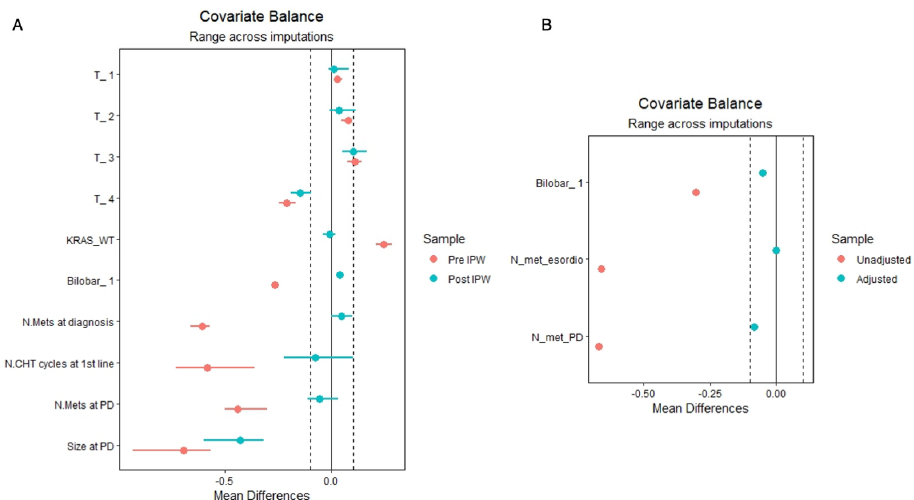
Figure 2. Love plots representing the effect of the weighting in terms of mean differences among the weighted variables. An optimal weighting has been reached if the green point falls between the vertical dashed lines. ( A ) the effect of IPW among patients who were in PD after a first line of chemotherapy and ( B ) the effect of IPW among those who were in PD even after a second line of chemo. Table 3. Baseline characteristics of the cohort submitted to second line chemotherapy before being Using this method, two pseudopopulations were created: 103.35 cases in the CHT considered for and 84.51 in the HEP group. OS values at one and three years were 54.4% and 10.6% for CHT and 97.8 and 49.3% for HEP (HR 0.256, 95%CI: 0.08–0.78, p = 0.033). The survival curve is depicted in Figure 1B.